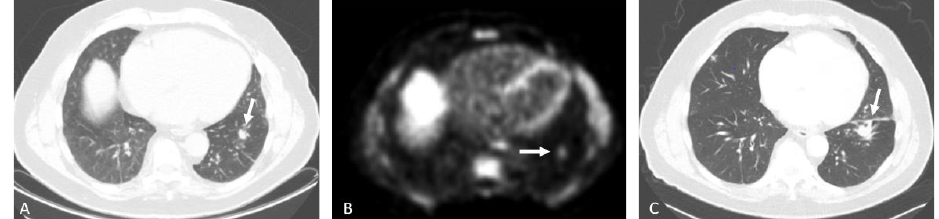
Figure 12. Eighty-four-year-old male with history of prostate cancer, status post-prostatectomy and radiation. NECT ( A ) and corresponding Axumin PET ( B ) images shows a spiculated, solid pulmonary nodule in the left lower lobe (arrows). NECT obtained one year later ( C ) shows the nodule to be increased in size (arrow), further raising suspicion. This was biopsy-proven to be metastatic prostate